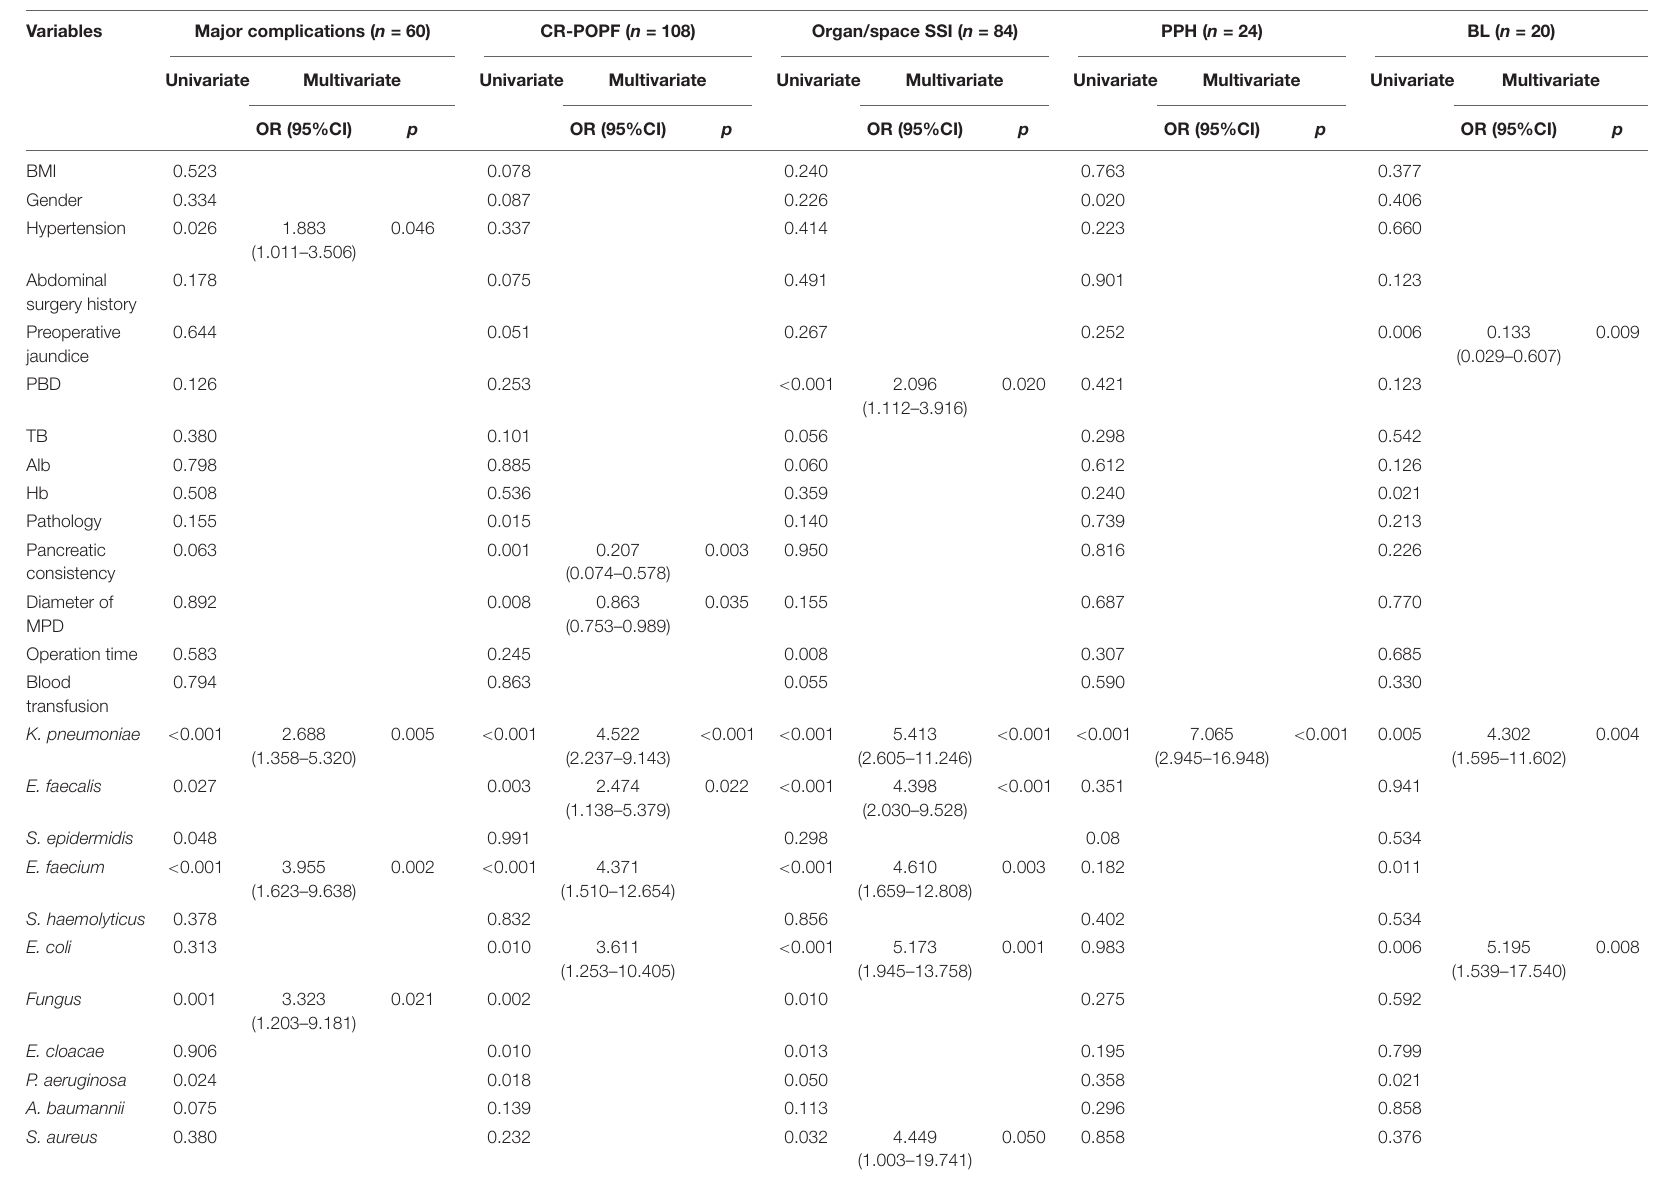
TABLE 5 | Univariate and multivariate analysis for risk factors of sever complication.